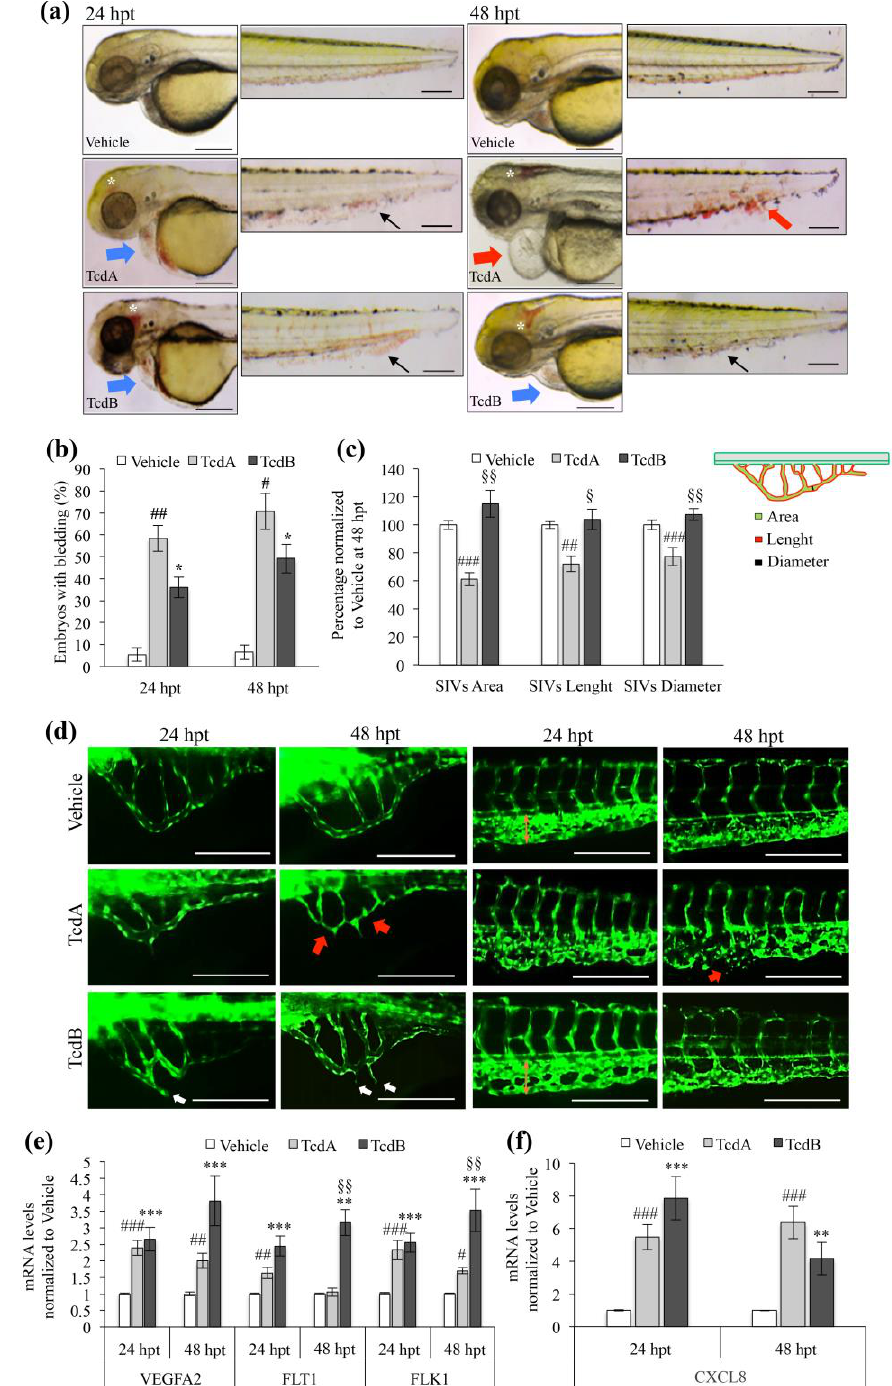
Figure 4. TcdA and TcdB induce different effects on the vascular system of zebrafish embryos. ( a ) Representative images of zebrafish embryos exposed to vehicle, 2.5 µg/mL TcdA or 8 µg/mL TcdB for 24 or 48 h. Vehicle-, TcdA- and TcdB-treated embryos are shown in the upper, middle and bottom panel, respectively. White asterisks indicate cerebral bleeding whereas black and red arrows show severe vascular damage observed at the tail level. Blue or red arrows indicate moderate or severe pericardial edema, respectively. Images were acquired with a Leica S8 AP0 stereo microscope. Scale bar = 200 µm. ( b ) The histogram showing the percentage of zebrafish embryos that exhibit bleeding after 2.5 µg/mL TcdA or 8 µg/mL TcdB addition. Data are presented as the mean ± SEM. ( n = 6), ( # p < 0.05, ## p < 0.01, * p < 0.05 compared to vehicle). ( c ) The area, length and diameter of the sub-intestinal veins (SIVs) are measured in zebrafish embryos 48 h after 2.5 µg/mL TcdA or